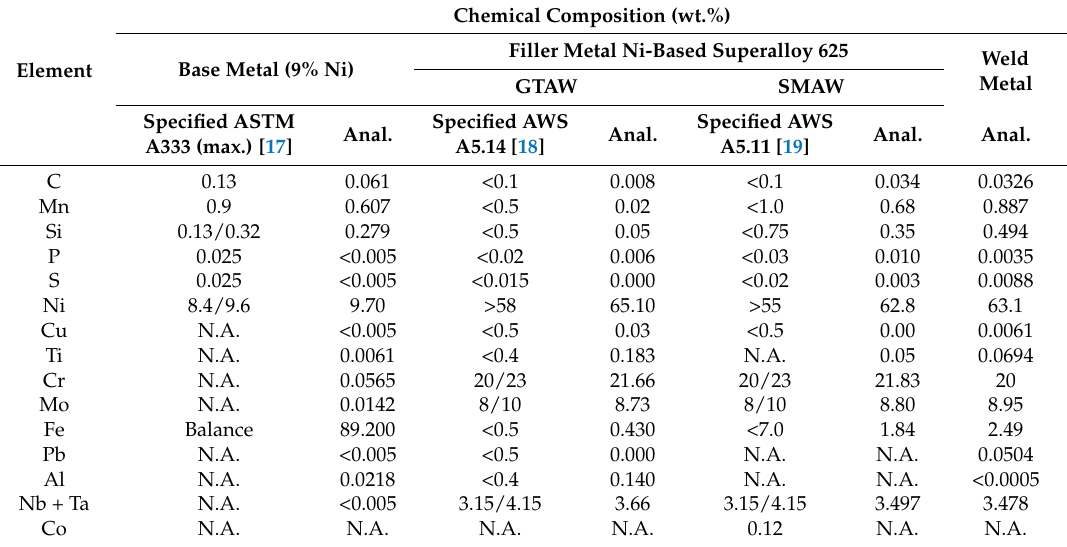
Table 2. Specified and analyzed chemical compositions (wt.%) of the base, filler and weld metals. Element